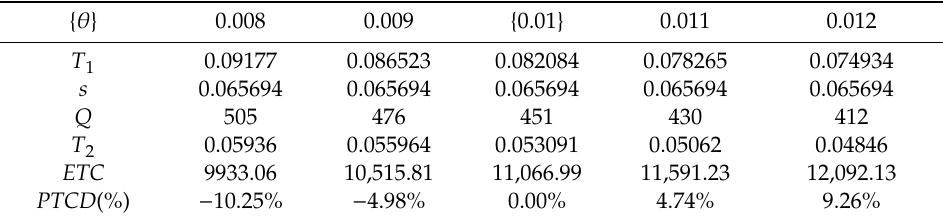
Table 2. Sensitivity analysis when the deteriorating rate